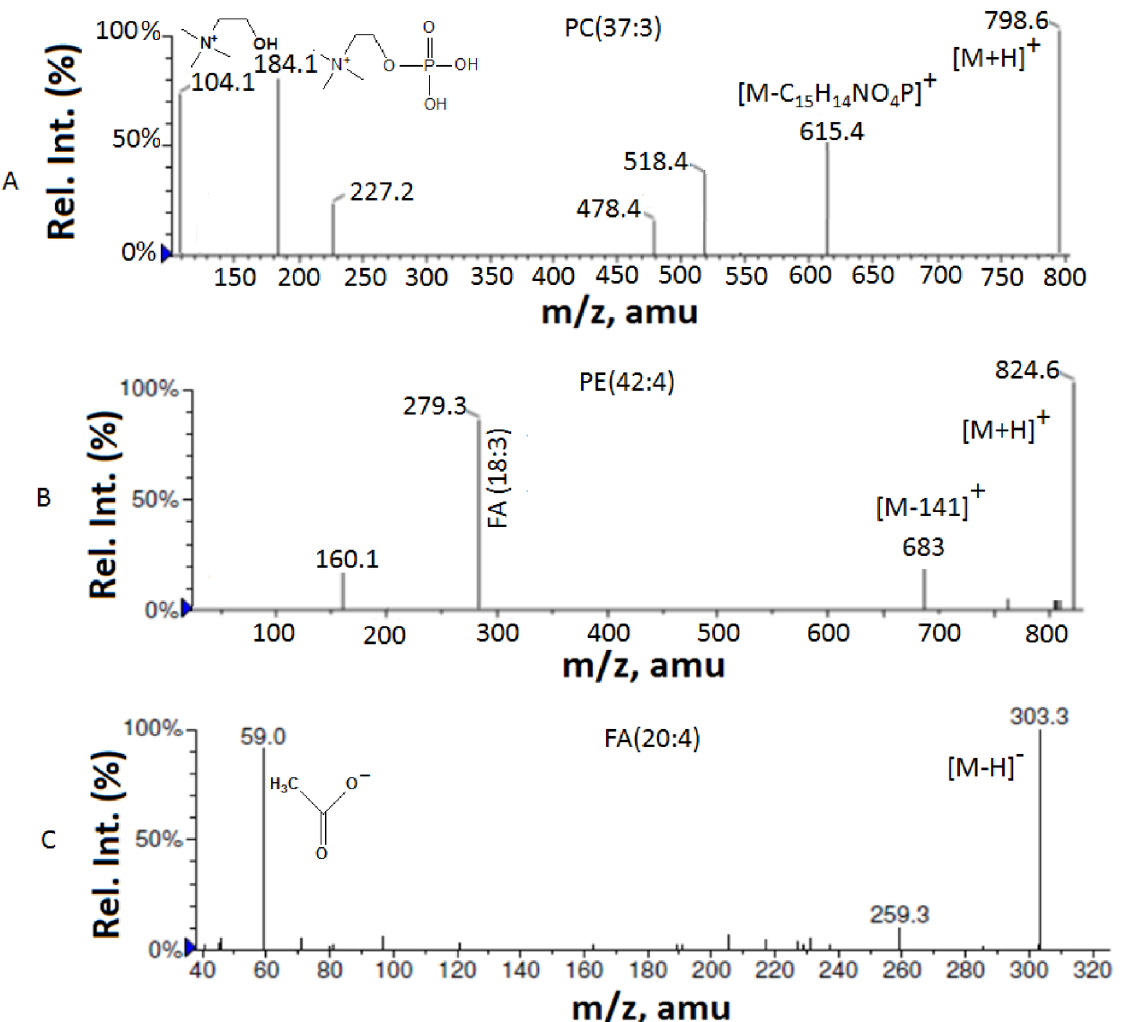
Fig 2. MS/MS spectra of a) [M+H] + ion of PC(37:3), b) [M+H] + ion of PE(42:4) and c) [M+H] + ion of FA(20:4).